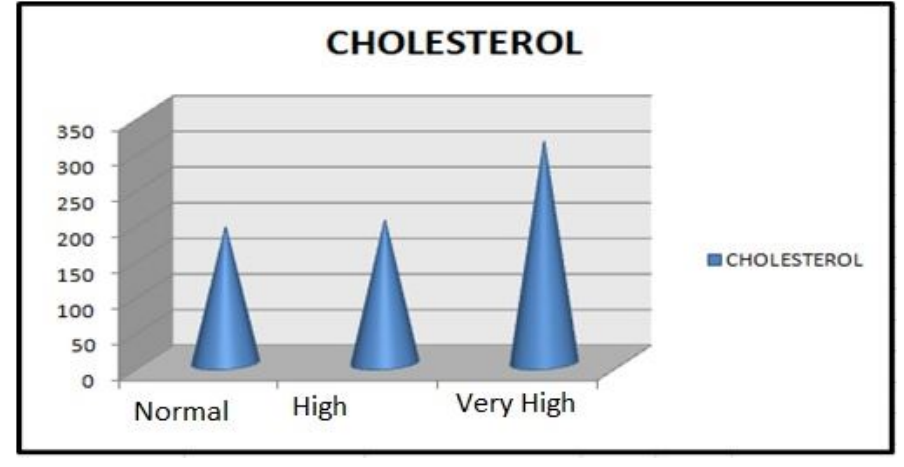
Figure 5. Cholesterol levels.